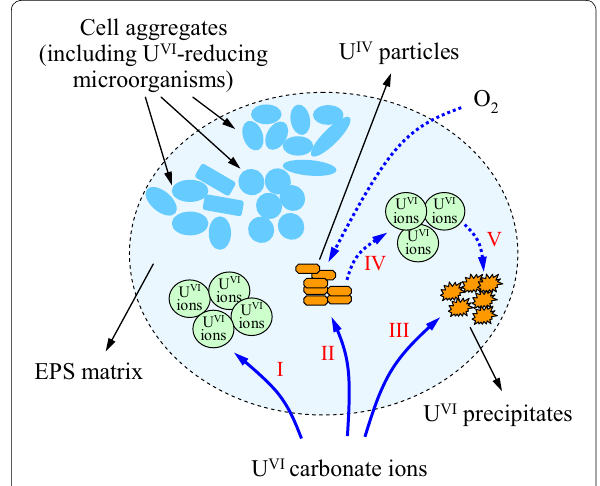
Fig. 6 The supposed roles of EPS in the U(VI) immobilization process by anaerobic sludge. Process I: U(VI) ions were adsorbed; Process II: U(VI) ions were reduced to U(IV) particles; Process III: U(VI) ions were precipitated to U(VI) particles; Process IV, V: if oxygen entered,